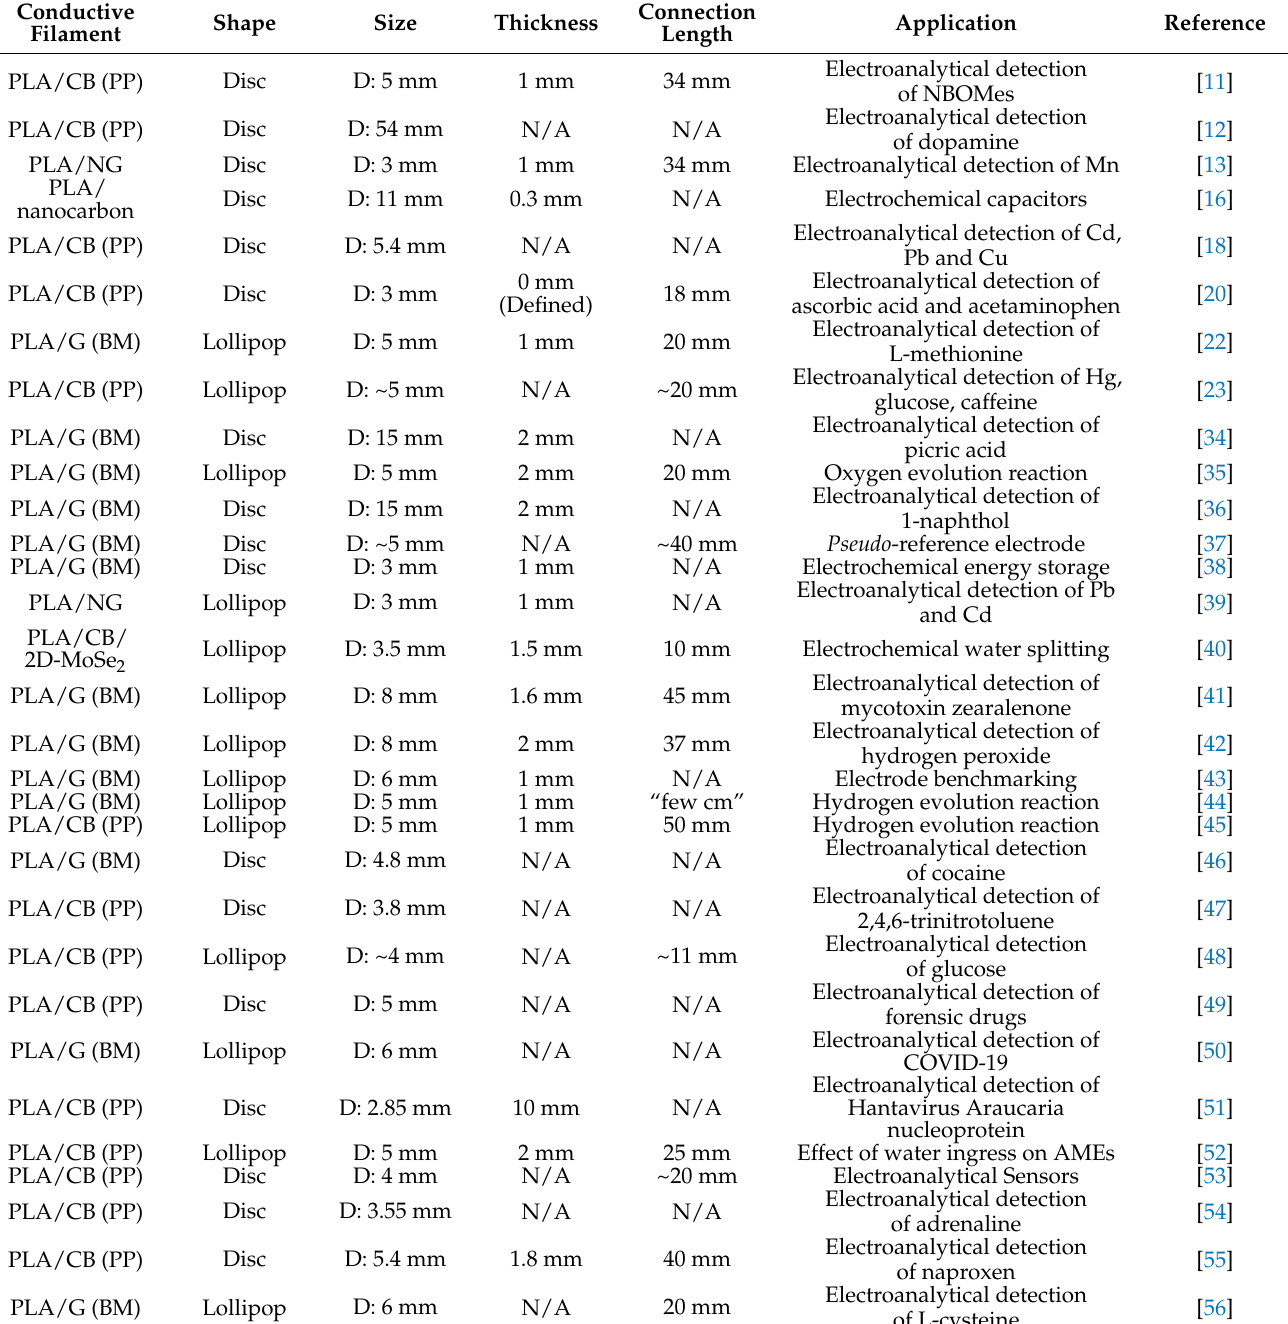
Table 1. A table comparing different FFF AMEs found in the literature. Comparing the shape, size, thickness, connection length, and the application of the